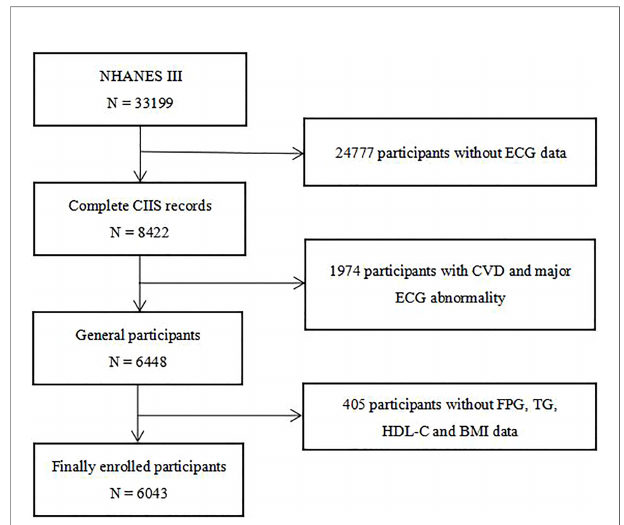
FIGURE 1 | Flow chart of the study population enrollment. NHANES III the third National Health and Nutrition Examination Survey, ECG electrocardiograph, CIIS cardiac injury/infarction score, CVD cardiovascular disease, FPG fasting plasma glucose, TG triglycerides, HDL-C high-density lipoprotein cholesterol, BMI body mass